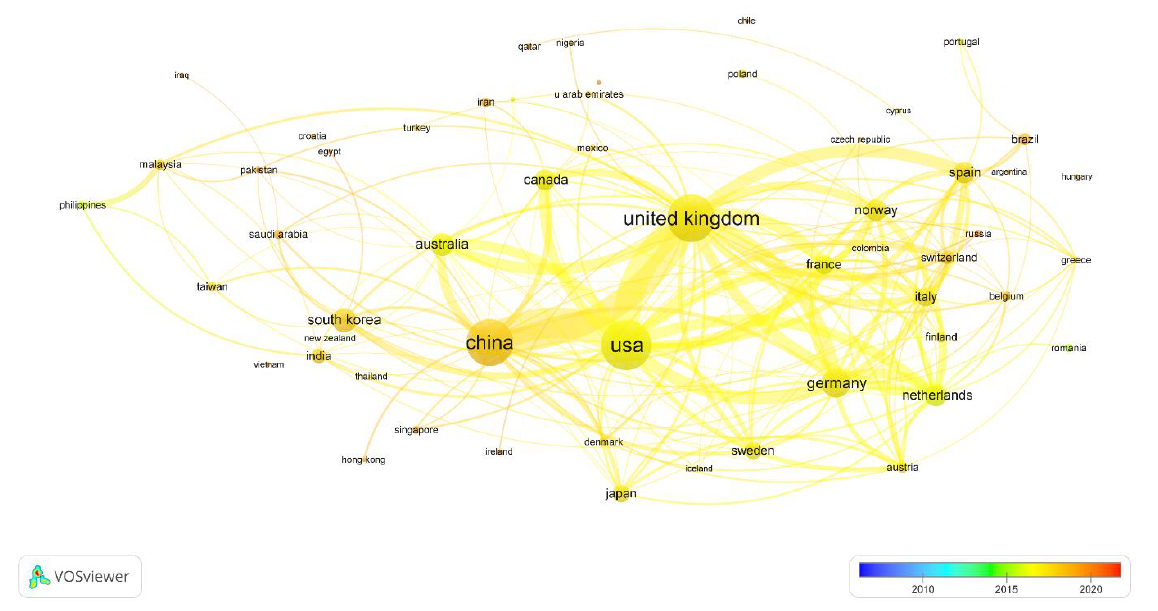
Figure 8. Network visualization map of research collaboration among countries/territories on carbon capture and utilization with a minimum of 5 publications.